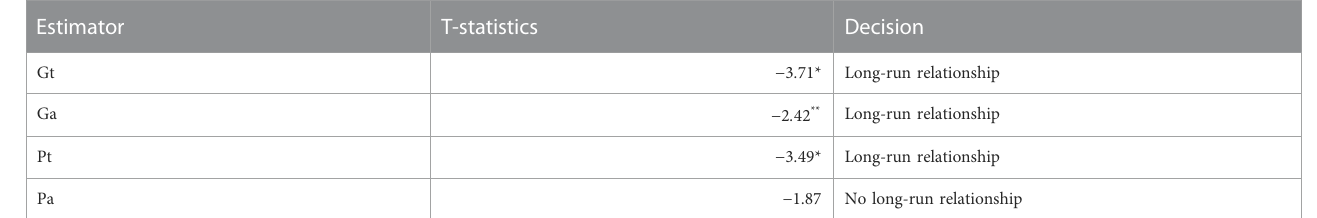
TABLE 3 Westerlund cointegration